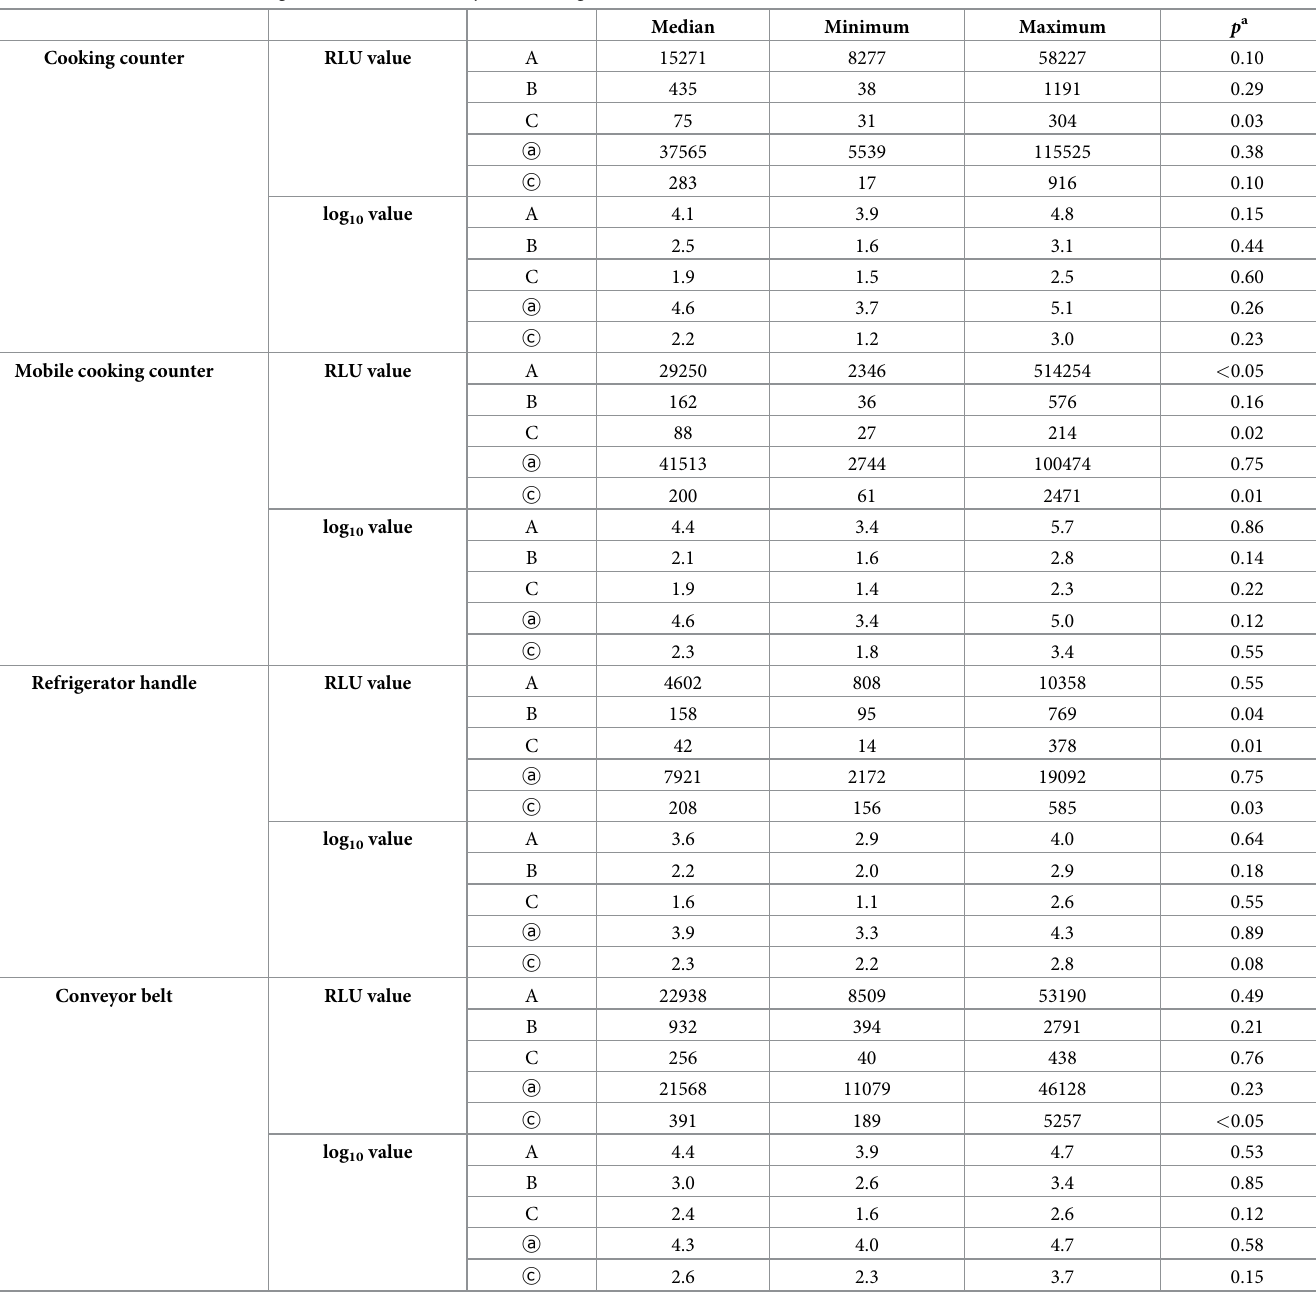
Table 1. Results of RLU values and log 10 values determined by ATP testing (n = 6). Cooking